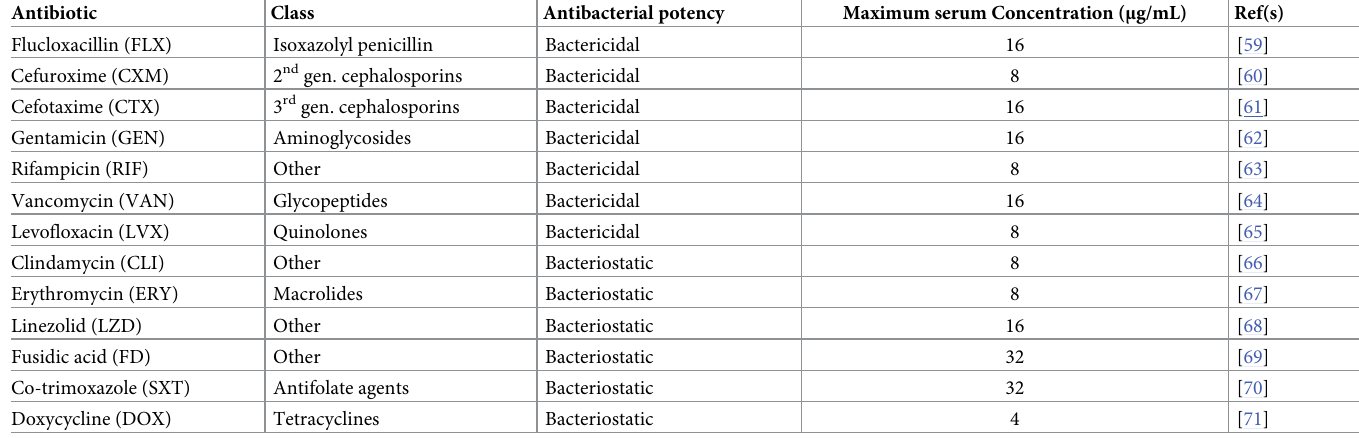
Table 2. List of